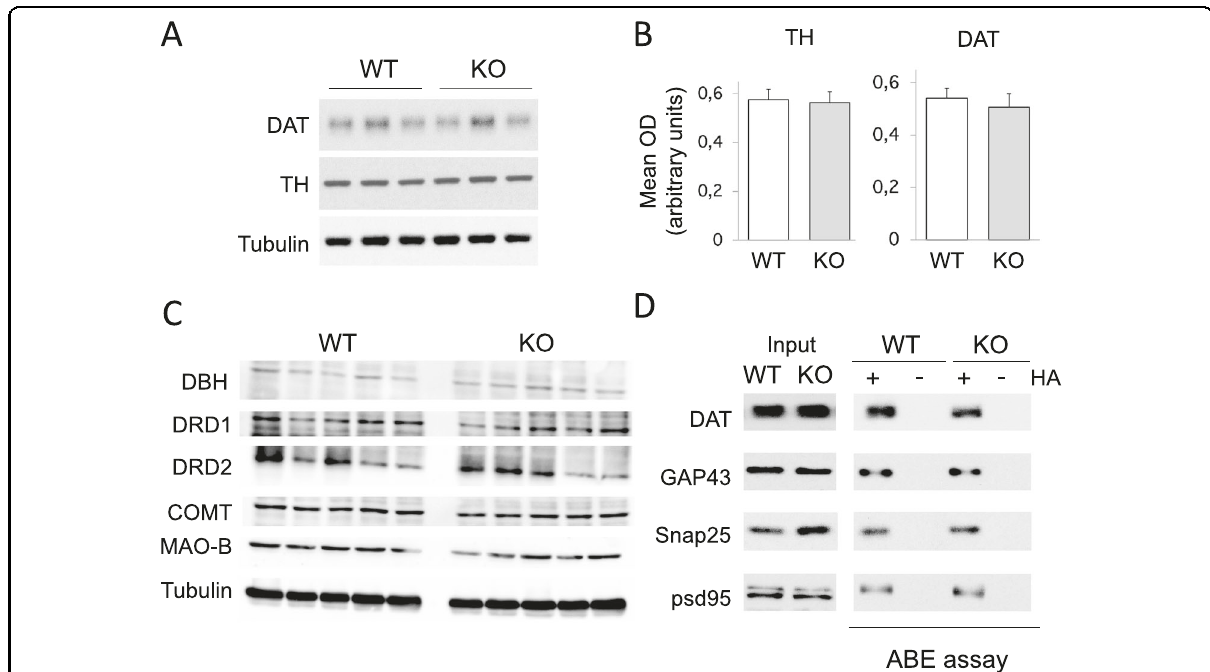
Fig. 5 Analyses of zdhhc15 substrates and proteins involved in DA metabolism in striatum of zdhhc15 -KO mice. A , B Western blot analyses of DAT and TH in striatal proteins extracts from zdhhc15 -KO and WT mice revealed no signi fi cant differences between the two genotypes ( n = 10 animals per group, student t -test). C Levels of other proteins involved in DA signaling and degradation were similar between WT and KO mice ( n = 5 animals per group; student t -test, p > 0.05). D Acyl-biotin exchange (ABE) assay was performed for quantitative analysis of protein palmitoylation in striatum from WT and zdhhc15 -KO mice. Representative blot signals of inputs (left) and ABE samples (right) in striatum of zdhhc15 -KO and WT mice are shown. No differences were found in the total level of proteins or in the palmitoylation levels of known DHHC15 substrates ( n = 5 – 6 animals per group; student t -test, p >